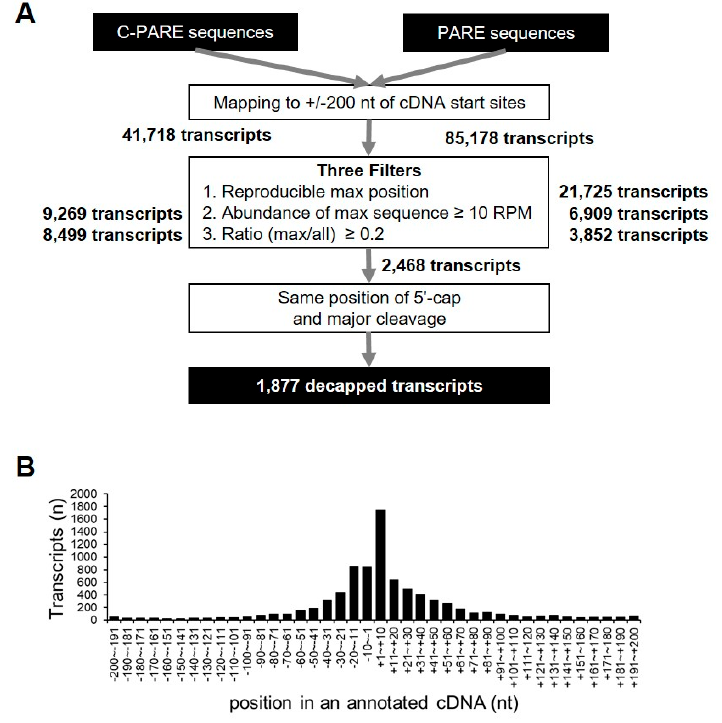
Figure 7. Identification of decapped transcripts. ( A ) Pipeline for the identification of decapped transcripts from C-PARE and PARE libraries. All C-PARE and PARE sequences were mapped to +/ − 200-nt regions of annotated cDNA transcription-start sites. The position of the 5 (cid:48) cap and the major cleavage site in a +/ − 200-nt window were identified using three filters and C-PARE and PARE sequences, respectively. The number of transcripts passing each filter is indicated in bold (right). The decapped transcripts were identified when the 5 (cid:48) -cap position and the major cleavage site were the same; ( B ) Distribution of the most abundant C-PARE sequences at a given position within the +/ − 200-nt position from the annotated transcription-start site of a gene is indicated on the